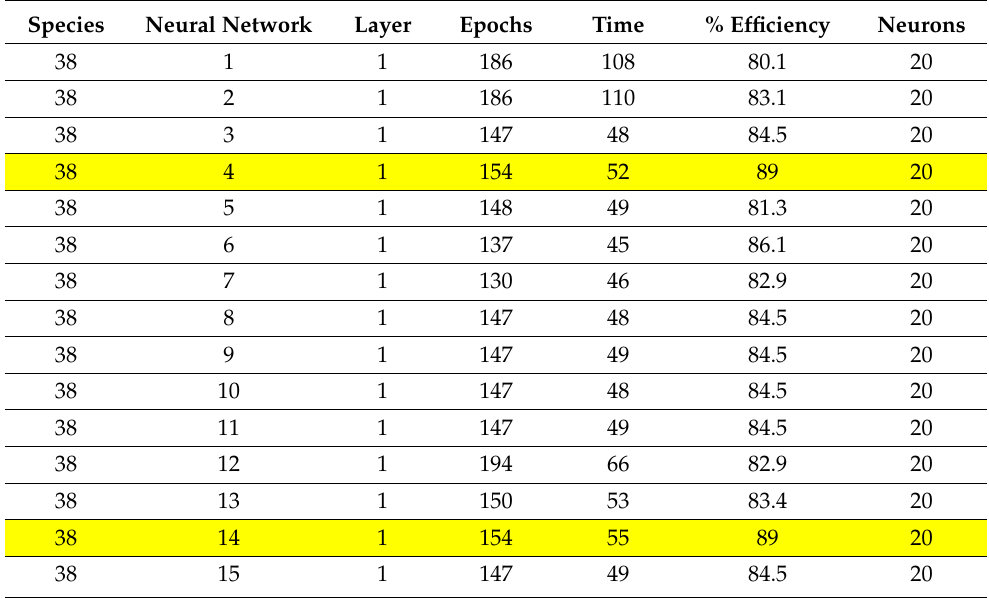
Table 6. Fourth experiment. Fifteen runs of the neural network with 37 species, 1 control group (38 “species”), and 20 neurons in the hidden